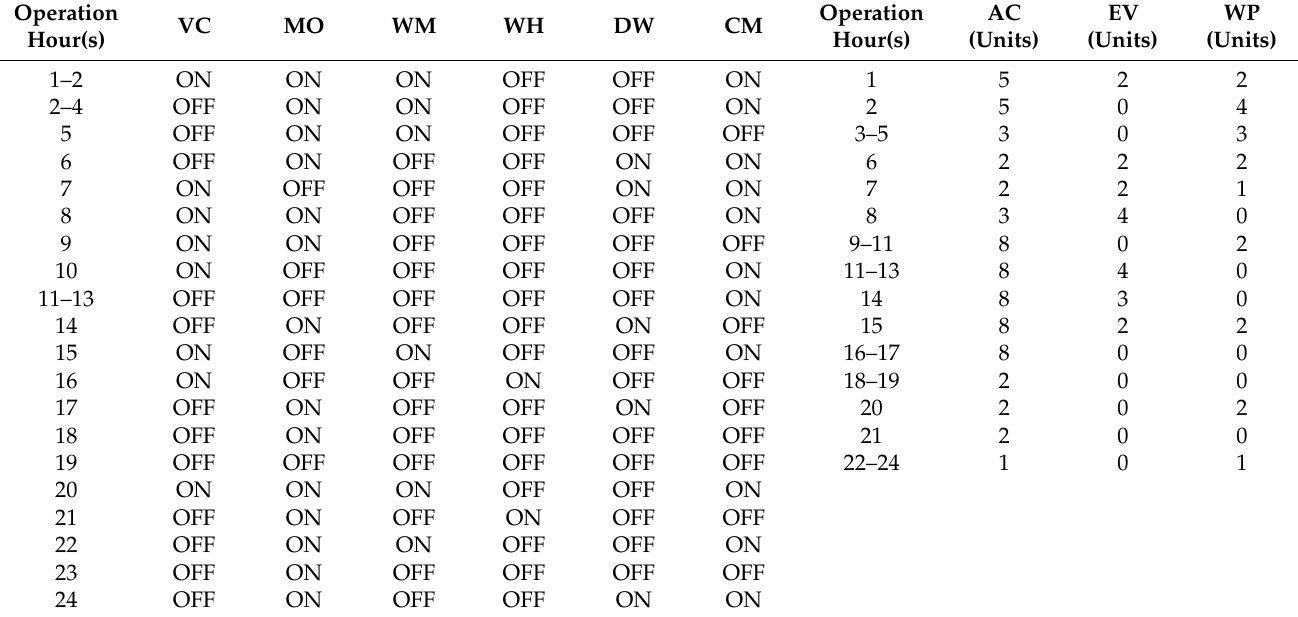
Table 2. Detailed operation hours and power consumption of shiftable/non-shiftable